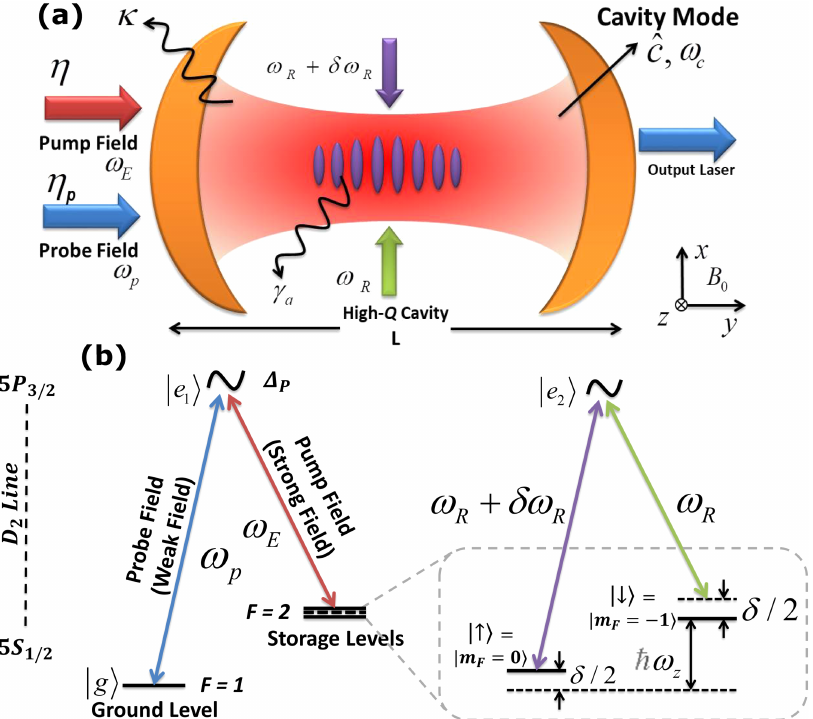
Fig. 1 Schematic system con fi guration. a Schematic setup for 87 Rb spin-orbit coupled Bose-Einstein condensate inside a high- Q cavity, driven by control pump fi eld ω E and a probe fi eld ω p . The bias magnetic fi eld B 0 is applied along the cavity ( ^ y -axis) while the Raman beams interact transversely ( ^ x -axis) with atoms. b The energy level excitation diagram, where left-side illustrates the probe-pump excitation of the atoms and right-side is the Raman excitation at storage level for spin-orbit p ffiffiffiffiffiffiffiffiffiffiffiffiffiffiffiffiffiffiffiffi p ffiffiffiffiffiffiffiffiffiffiffiffiffiffiffiffiffiffiffiffiffiffi are the intensities of and j η P ´ κ = _ ω E P p ´ κ = _ ω p p j ¼